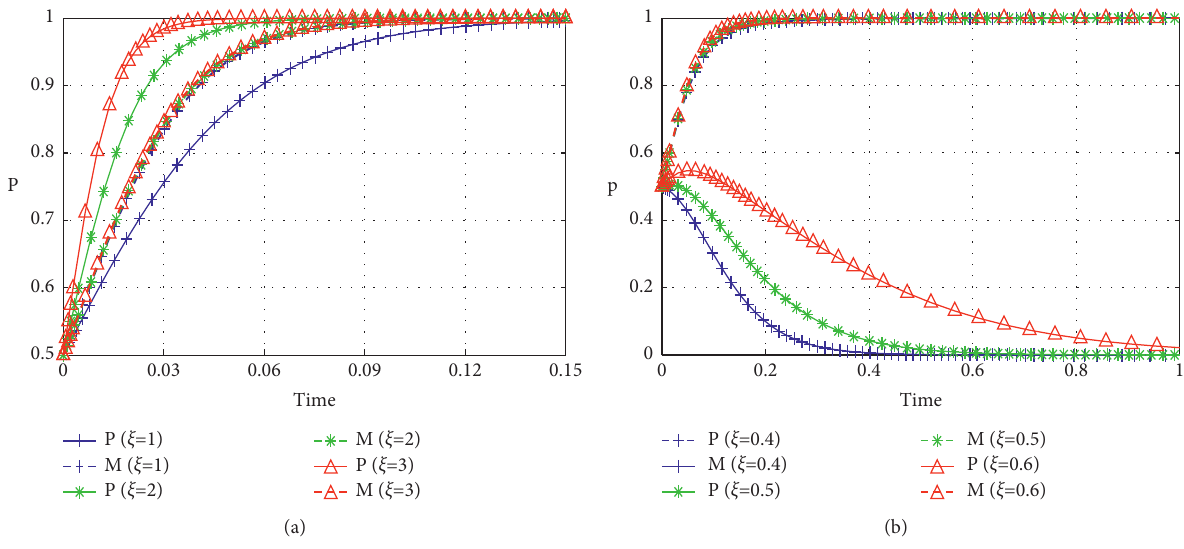
Figure 4: The impacts of network externality in different cases. (a) Case 1. (b) Case